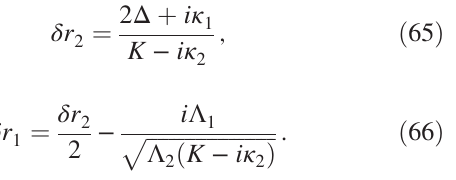
FIG. 7. Extreme parameter sensitivity near a quantum-bistable point. Bottom row: Wigner function for the purification ψ Kerr-cavity steady state for various parameter choices that are close to the ð r 1 ; r 2 Þ ¼ ð 0 ; 0 Þ quantum-bistable point. For all plots